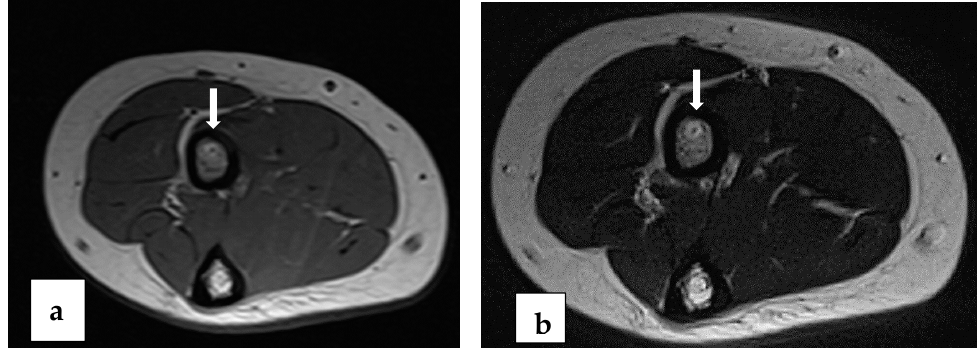
Figure 3. T1-weighted ( a ) and T2-weighted ( b ) axial images with bright halo (white arrow) surrounding a faint residual of BIN in radial bone. Table 3. Imaging findings of biodegradable nails in MR.